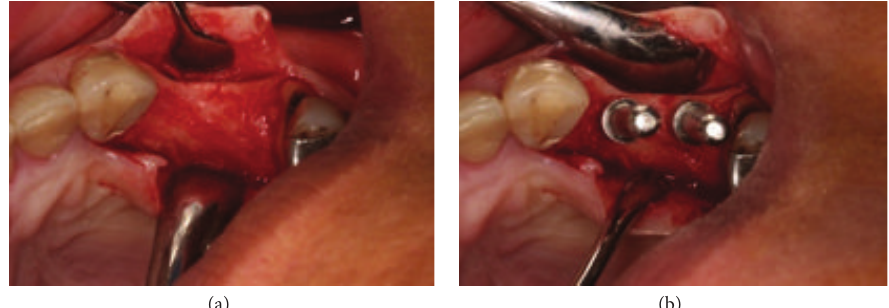
Figure 3: Full-thickness flap, showing the bone (a) and seating tip in position (b) (November 2008).